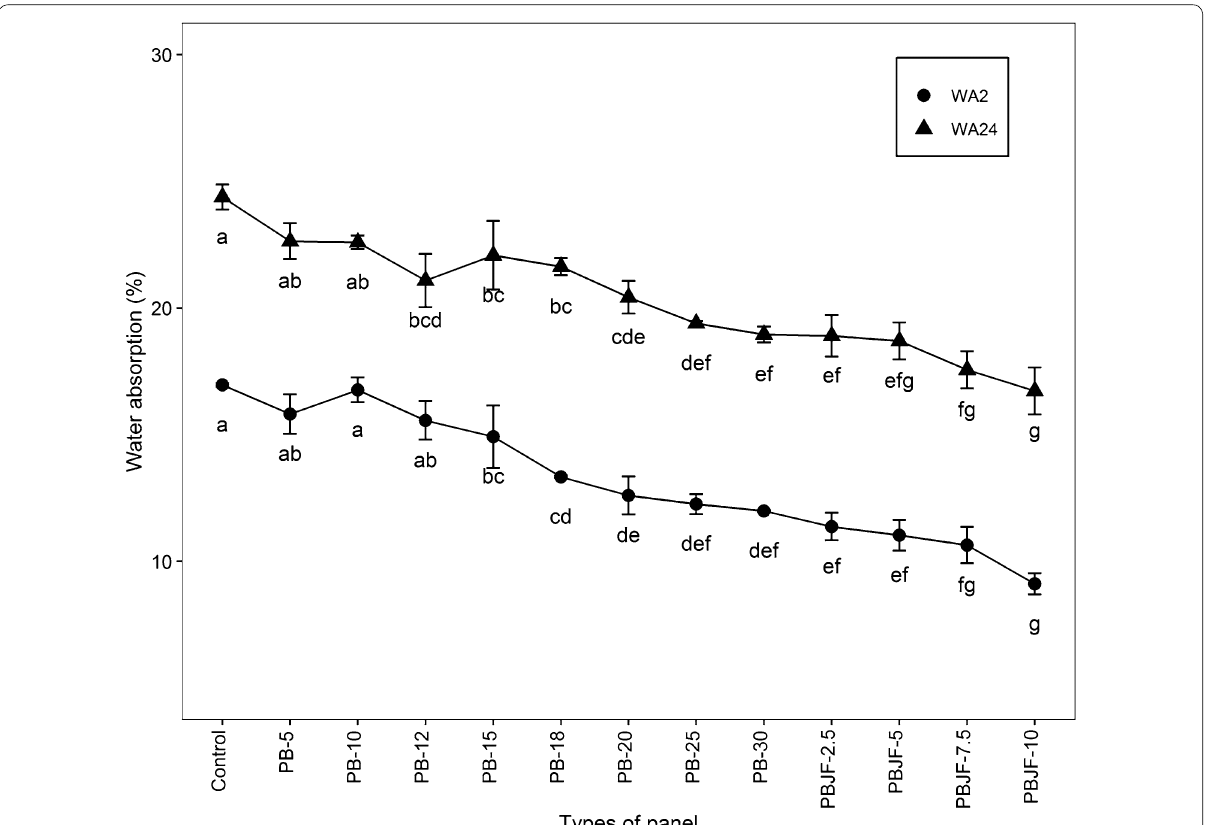
Fig. 2 Water absorption variation for different types of CBCs after 2 and 24 h of immersion in water. Different letters below each point indicate statistically significant differences among groups ( p <